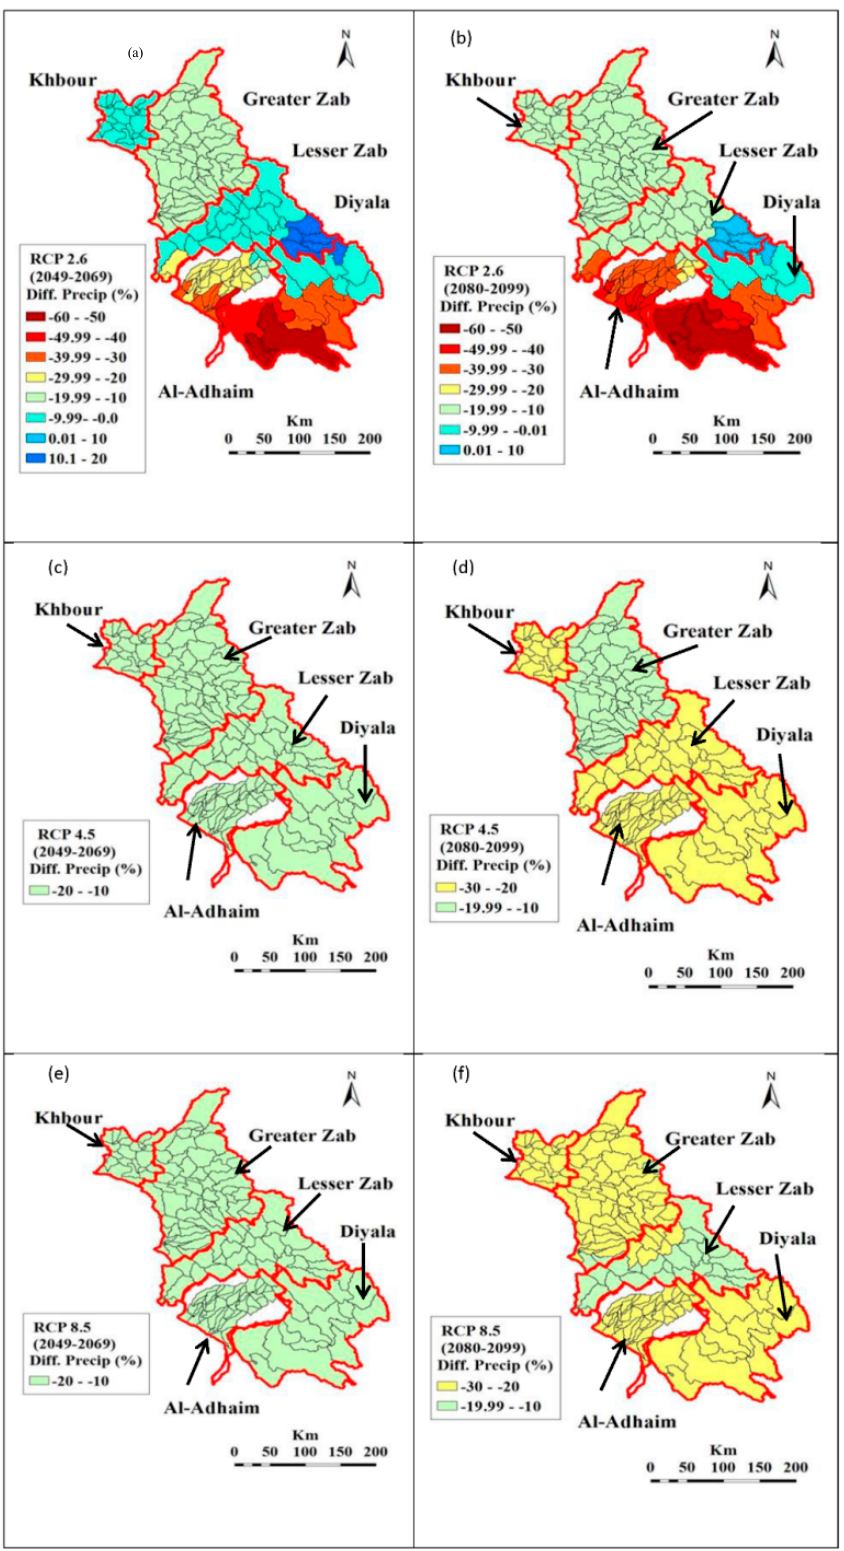
Figure 7. The impacts of climate change on the precipitation of the five basins ( a ) Anomaly based on scenario RCP2.6 for the period 2049–2069, ( b ) Anomaly based on RCP2.6 for 2080–2099, ( c ) Anomaly based on RCP4.5 for 2049–2069, ( d ) Anomaly based on RCP4.5 for 2080–2099, ( e ) Anomaly based on RCP8.5 for 2049–2069, and ( f ) Anomaly based on RCP8.5 for 2080–2099.